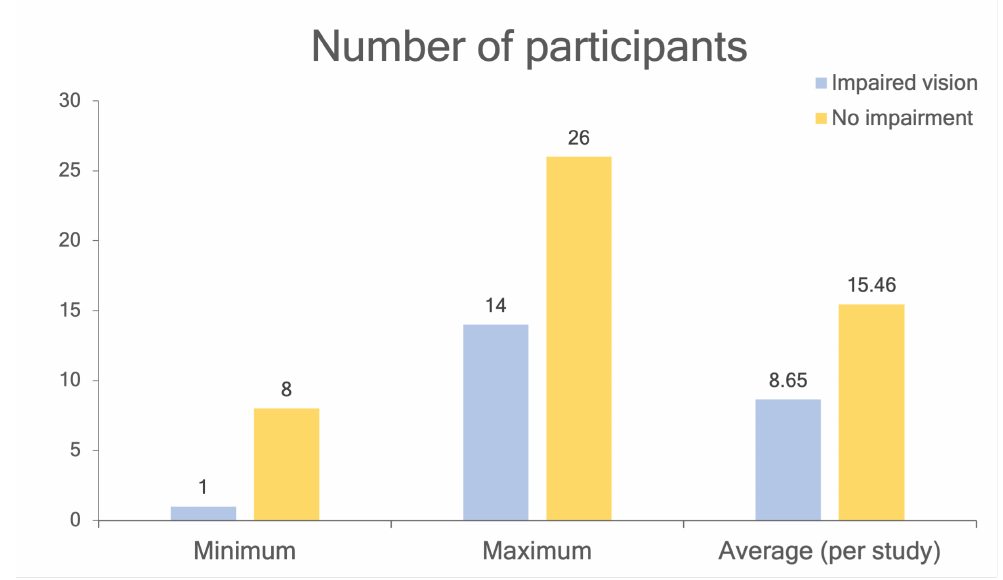
Figure 5. Participation levels in experiments reported by